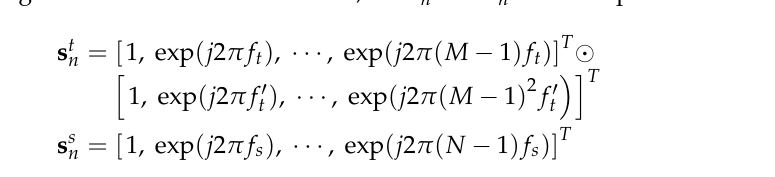
where c is the speed of light. We can clearly infer from Equation (3) that the Doppler fre- quency has changed because of acceleration. So, the s t